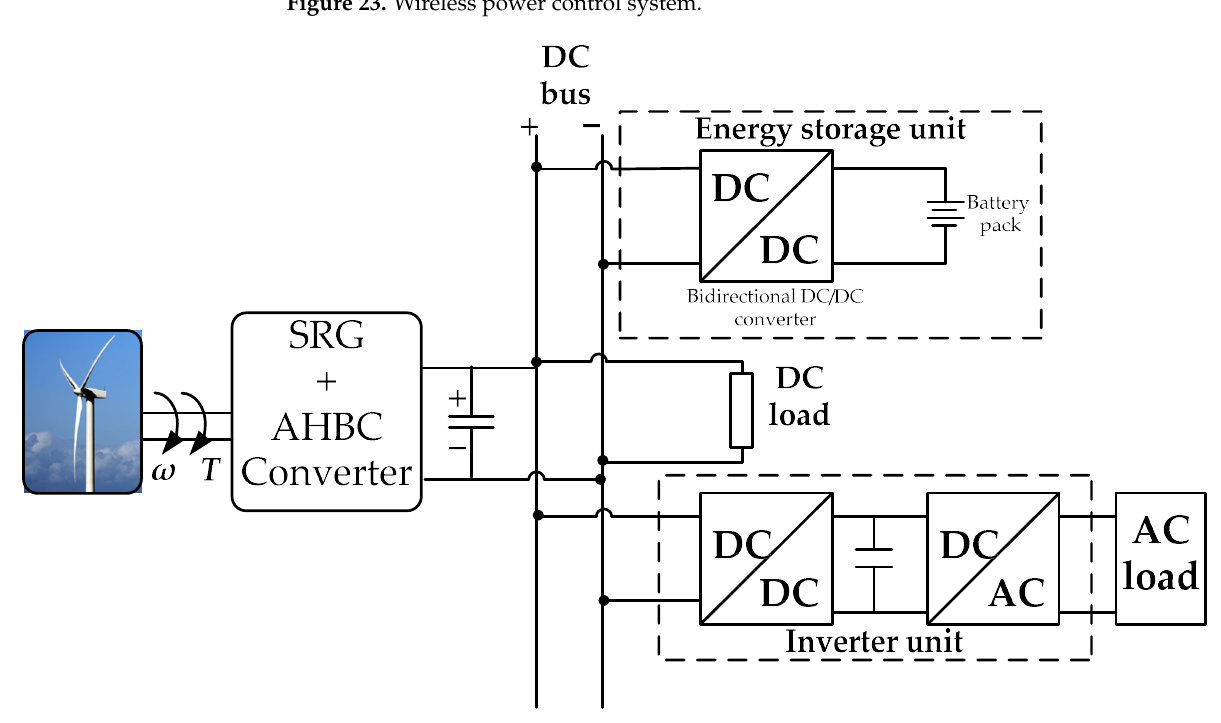
Figure 24. Small-scale wind power system based on the integrated energy storage system.